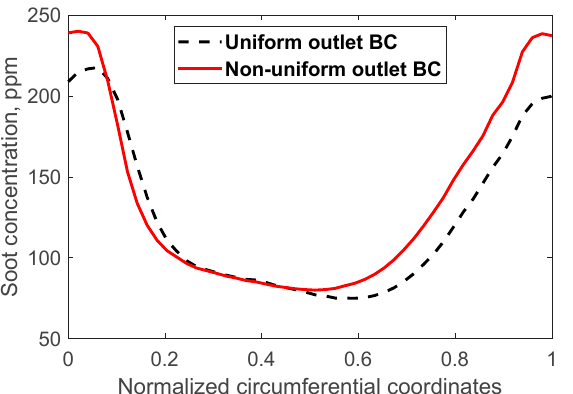
Figure 13. Soot concentration circumferential distribution at the combustor outlet mid-span.